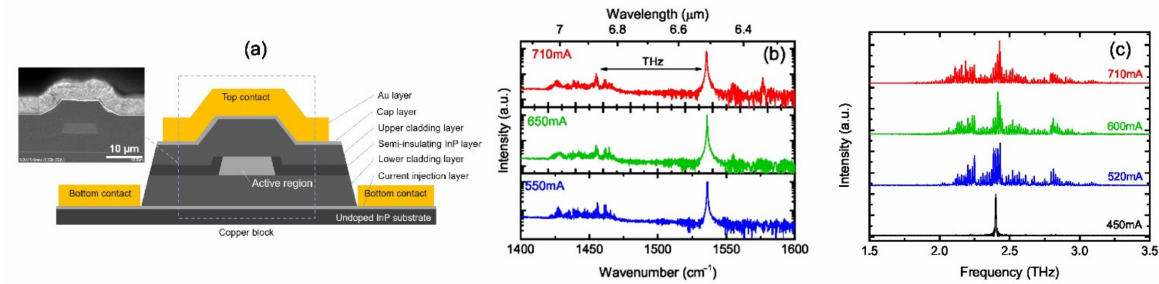
Figure 1. ( a ) Schematic of the THz difference frequency generation quantum cascade laser (DFG-QCL) and scanning electron microscope (SEM) image of the device. Mid-infrared ( b ) and THz ( c ) spectra at different currents of the DFG-QCL at the temperature of 78 K used in this study. The cavity length is 3 mm and the ridge width is 12 µ